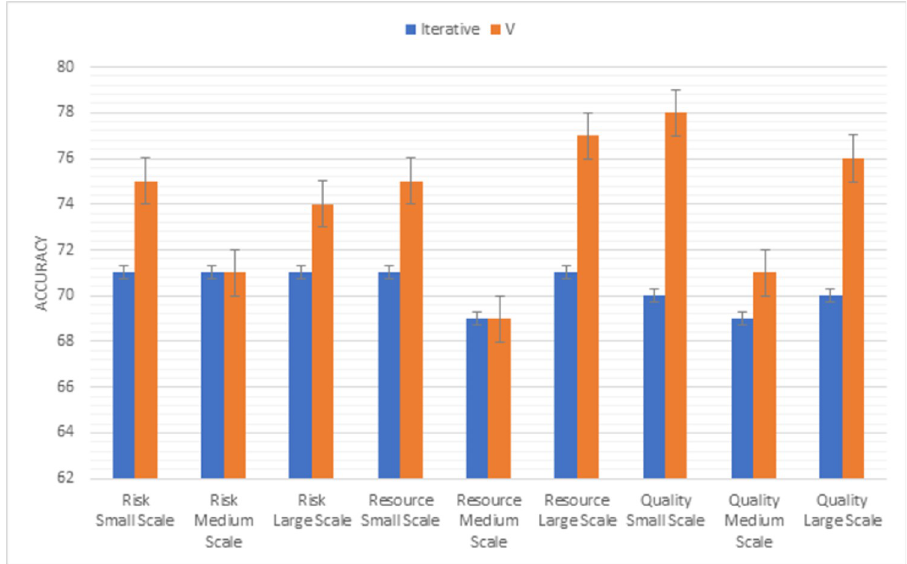
Fig 12. Graphical representation of iterative vs V (second triangle) results.